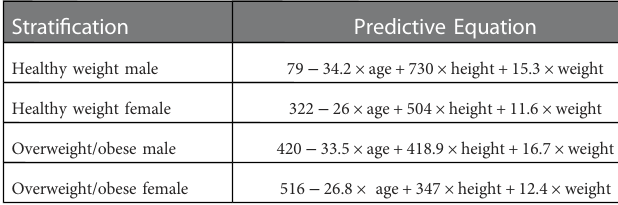
TABLE 2 The Institutes of Medicine estimated energy requirement equations. Strati fi cation Predictive